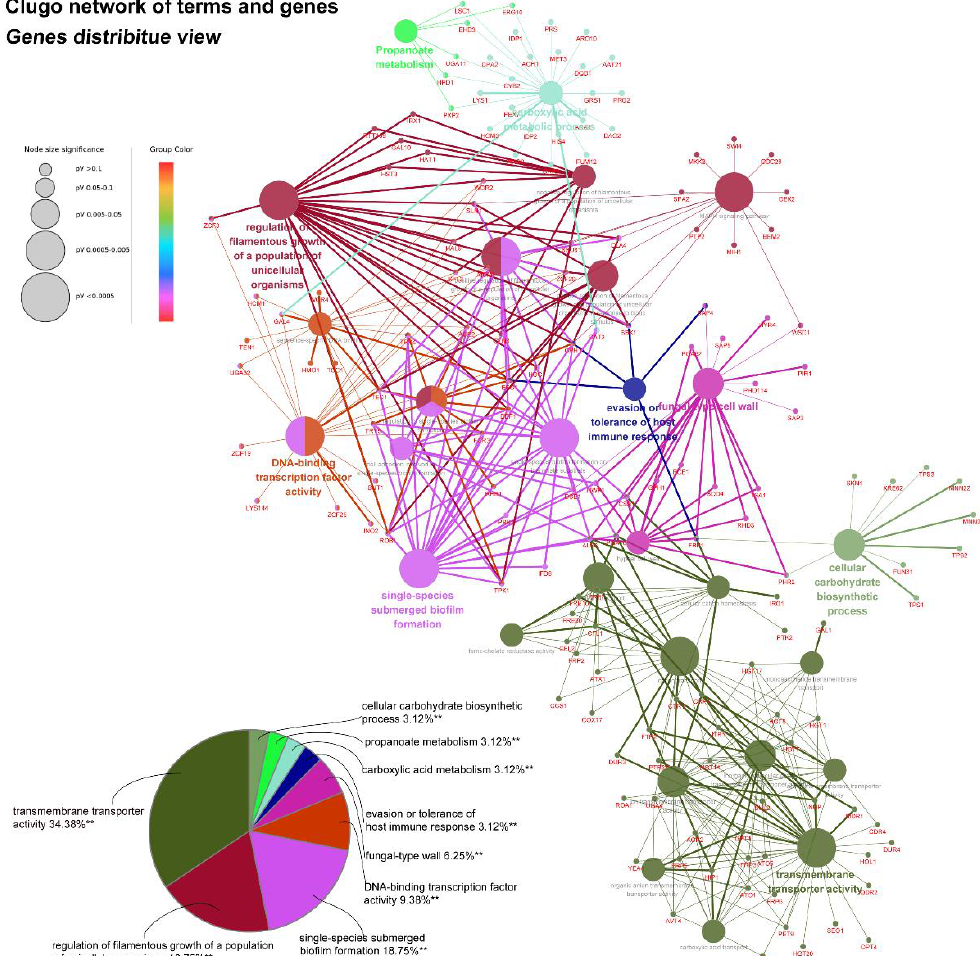
Figure 8. The network of DEG construction and analysis. The Clugo network of terms for DEGs co-expressed in the two pairwise comparisons. Overlapping targets were enriched based on the GO enrichment and the KEGG signaling pathways which clustered into the nine groups. Kappa score = 0.4 was considered. ** p < 0.01 were obtained for control versus treated samples.